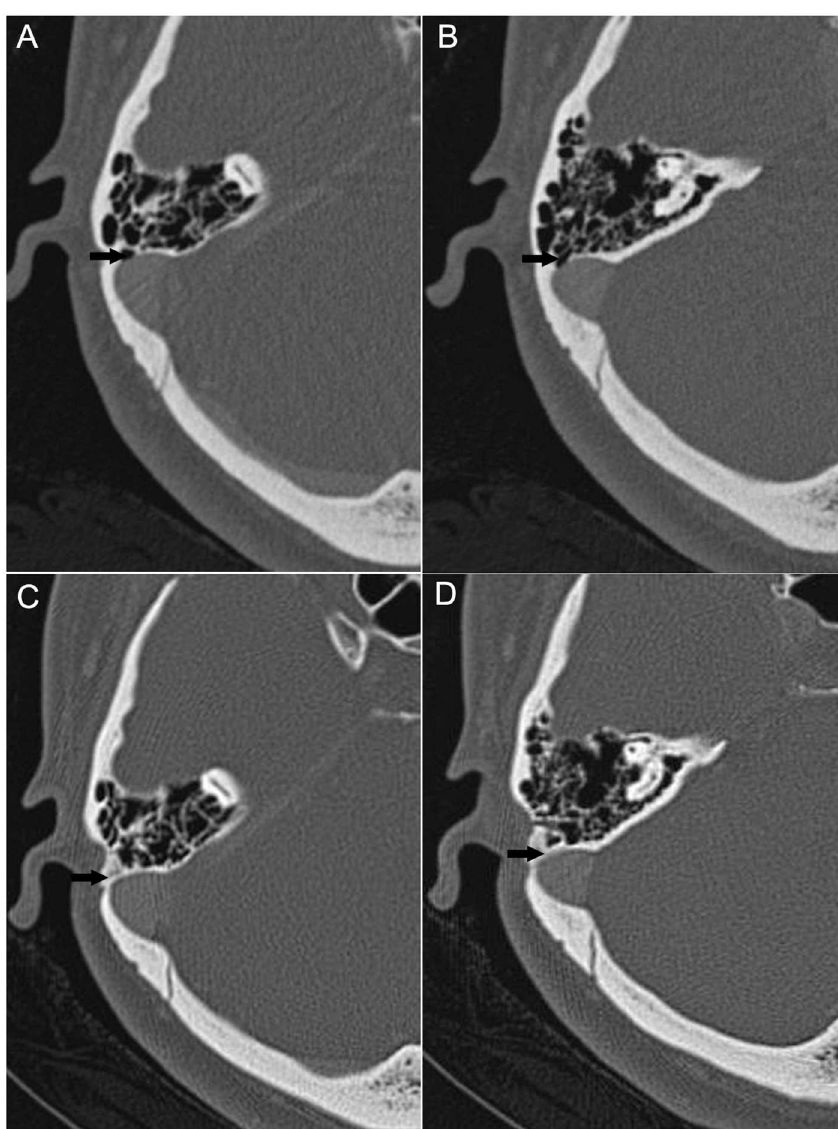
respectively. The dehiscences are completely repairedin the two layers postoperatively